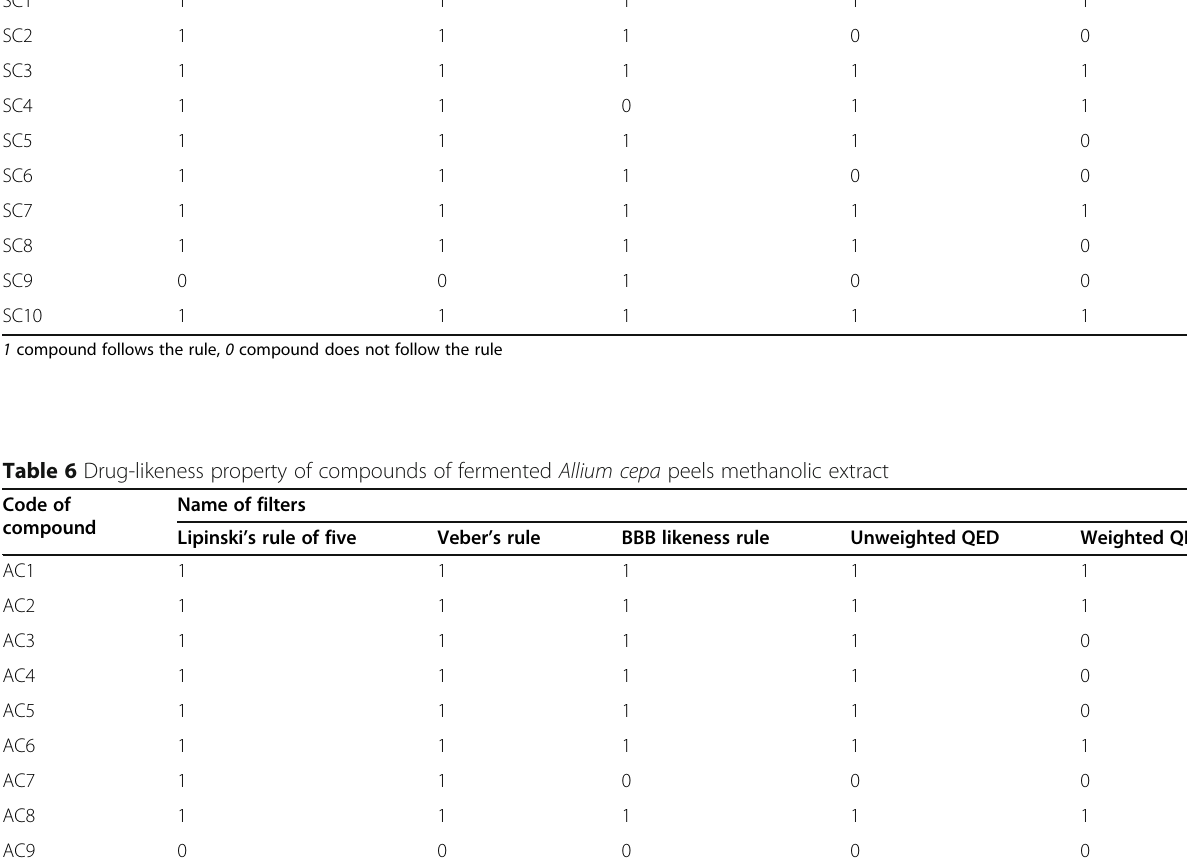
Table 5 Drug-likeness property of compounds of fermented Syzygium cumini seed methanolic extract Code of compound